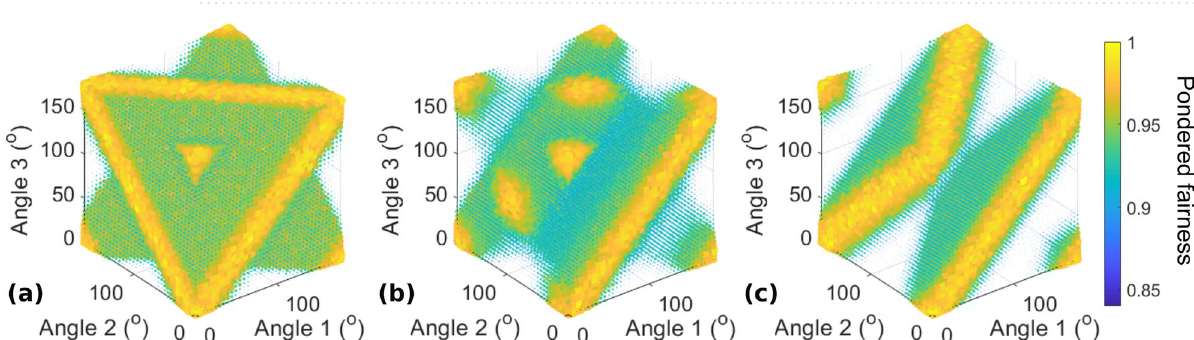
Figure 6. ( a ) Total reward, ( b ) fairness, and ( c ) pondered fairness I p for N = 4 users and tune their waveplates and the fourth remains static at 0°.